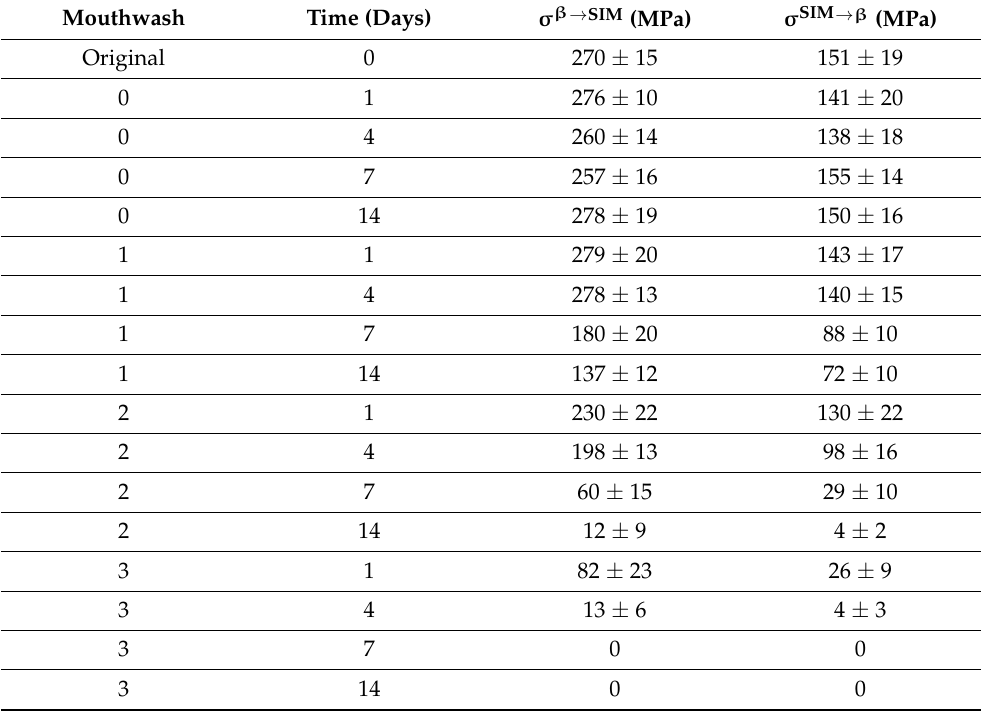
Table 4. Critical stresses at different test times for each mouthwashes